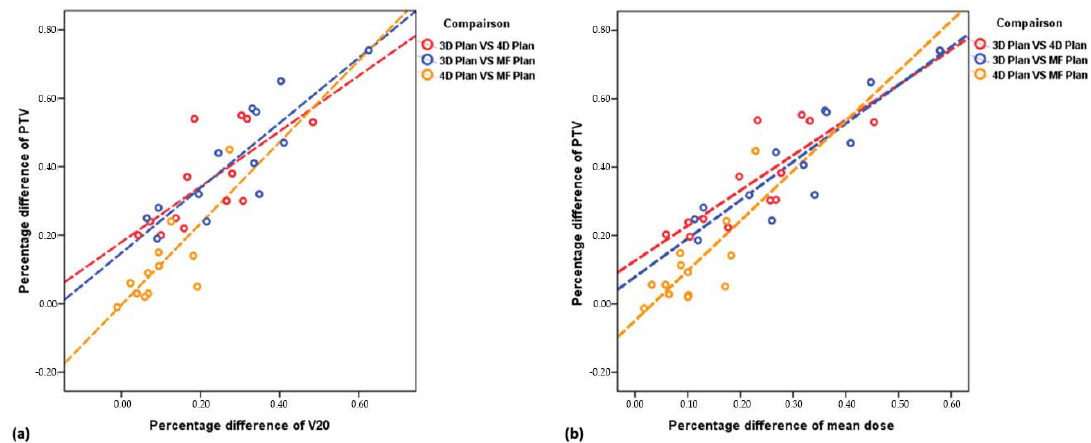
Figure 8. ( a ) Correlation between the percentage difference in the PTV and the percentage difference in the V 20 (the relative volume of the lung receiving a dose above 20 Gy); ( b ) correlation between the percentage difference in the PTV and the percentage difference in the mean dose of the lung. The red lines indicate the 3D-Plan vs. 4D Plan; the blue lines indicate the 3D-Plan vs. MF-Plan; and the yellow lines indicate the 4D-Plan vs. MF